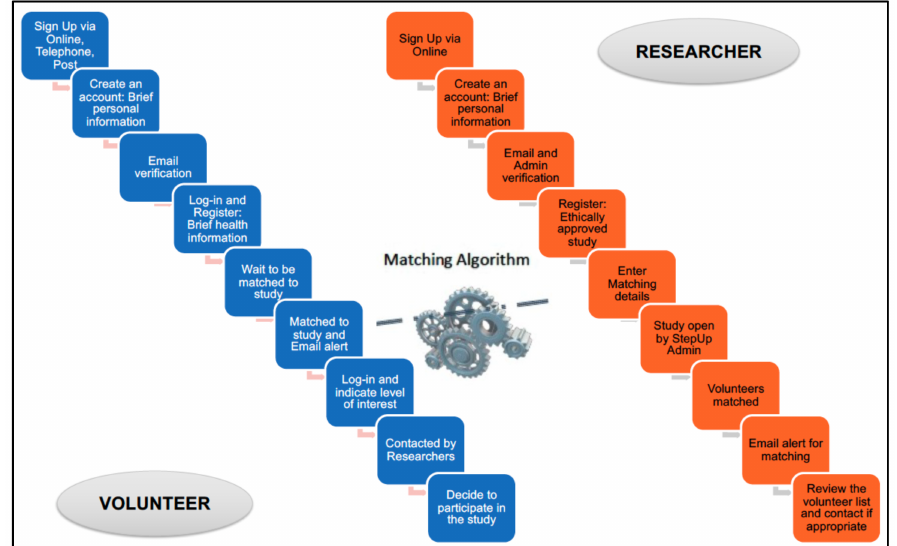
Figure 1. Registration and matching processes.